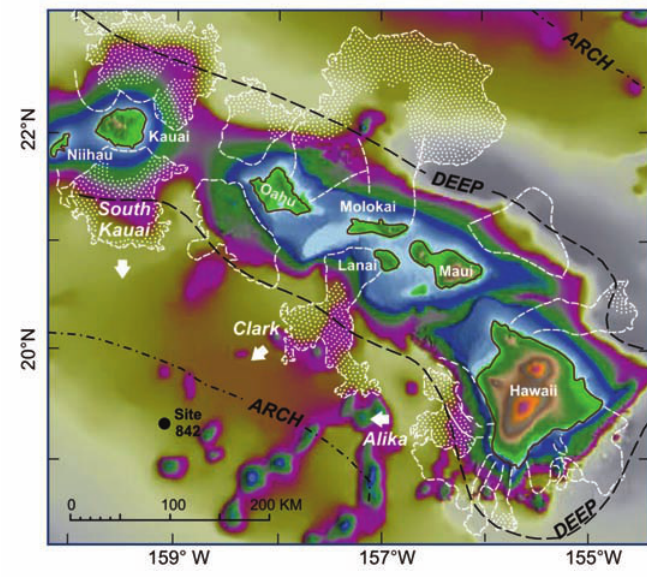
Figure 2. Map of Hawaiian Islands showing the major submarine landslides, indicated by white dashed lines and dots. Landslide deposits from Moore et al. [1989]. According to volcanic glass contents, site ODP 842 (solid black dot) shows traces of the Alika Slide from Mauna Loa Volcano (Hawaii Island), Clark Slide from Lanai, and the South Kauai Slide from Kauai [after Gracia 1999]. The axis of the Hawaiian Deep is shown by a heavy dashed line; the Hawaiian Arch axis is shown by the heavy dashed-dotted line. The difference of level between Site ODP 842 and the bottom of the Hawaiian Deep is about 500 m. Colors of the bathymetric image are: medium blue lower limit marks 1000 m depth, dark blue lower limit marks 2000 m, green lower limit marks 3000 m, cyclamen lower marks limit 4000 m, light olive-green lower limit marks 5000 m, grey tones correspond to depths lower than 5000 m. The bathymetric image is the file http://www.vterrain.org/Hawaii/Elevation/keating.jpg, down- loaded from the web page of the Virtual Terrain Project (VTP): http://www.vterrain.org/Hawaii/Elevation/. It was produced by a group including: the Hawaii Mapping Research Group, the School of Ocean and Earth Science and Technology of the University of Hawaii at Manoa, the Hawaii Undersea Research Laboratory and the NOAA’s Pacific Islands Benthic Habitat Mapping